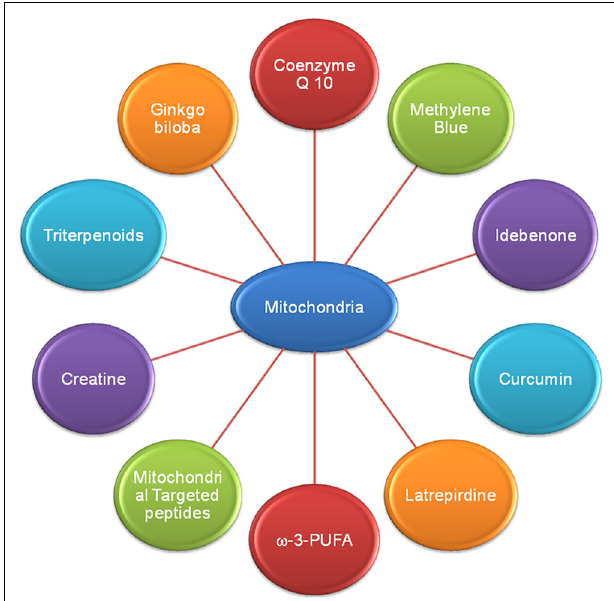
FIGURE 3 | Various drugs and natural compounds with common potential therapeutic target mitochondria in Alzheimer’s disease.